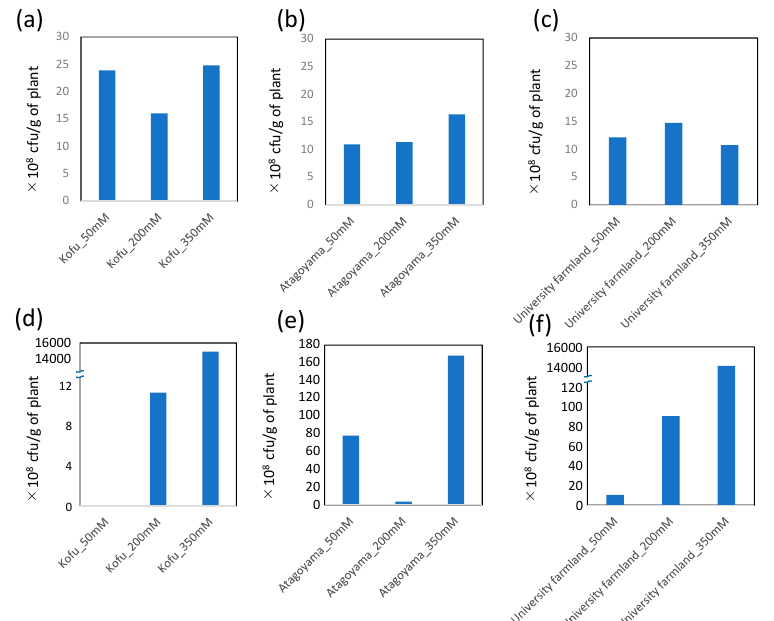
Figure 2. Microbes obtained from rhizosphere soil ( a – c ). Endophytic bacterial colony forming units of microbes isolated from ice plants growing in different soils ( d – f ). Values are means ( n = 2).